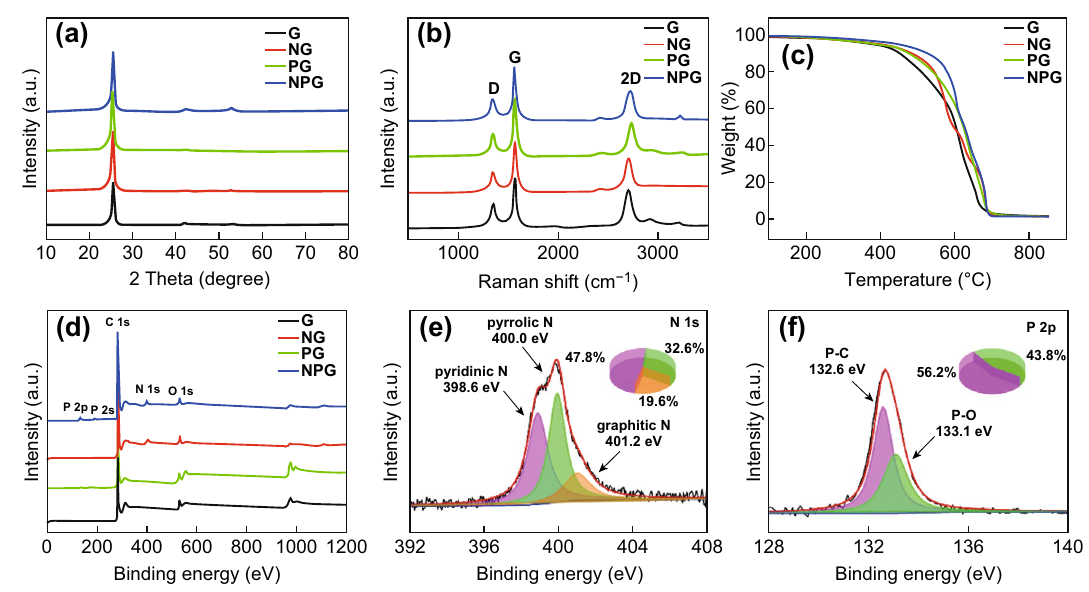
Fig. 3 a XRD patterns, b Raman spectra, c TGA curves, as well as d full and high-resolution e N 1 s and f P 2 p XPS spectra of the NPG sample